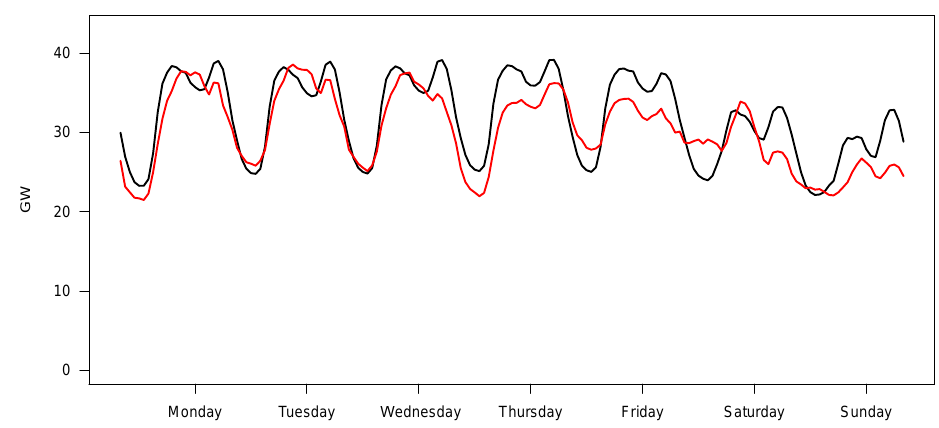
Figure 11. A comparative plot between the current demand (black line) and the new generation based on the substitution of coal with the optimized VRES mix (red line) proposed in our model: The sample corresponds to the week between hour 528 and hour 696 of the year.